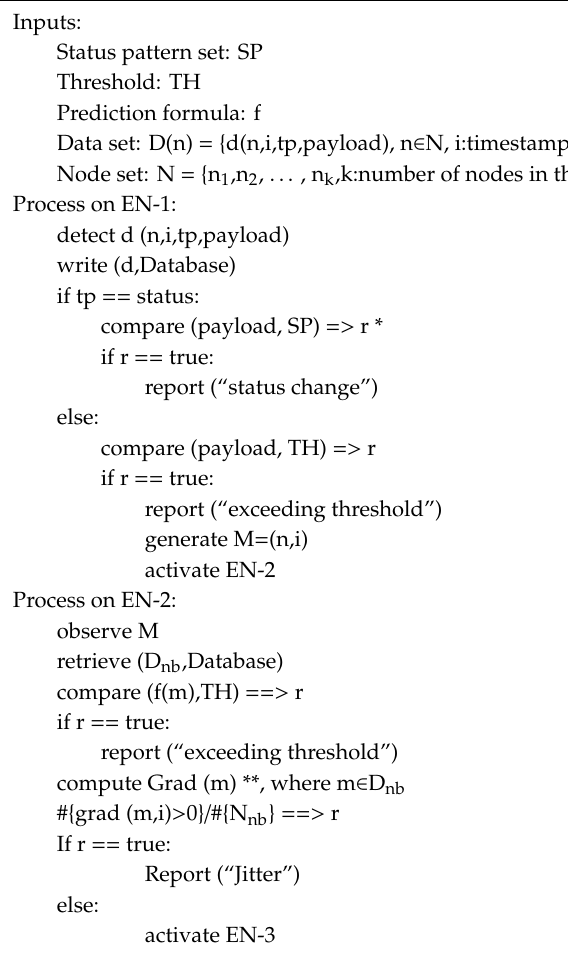
Algorithm 1 Rapid response strategy